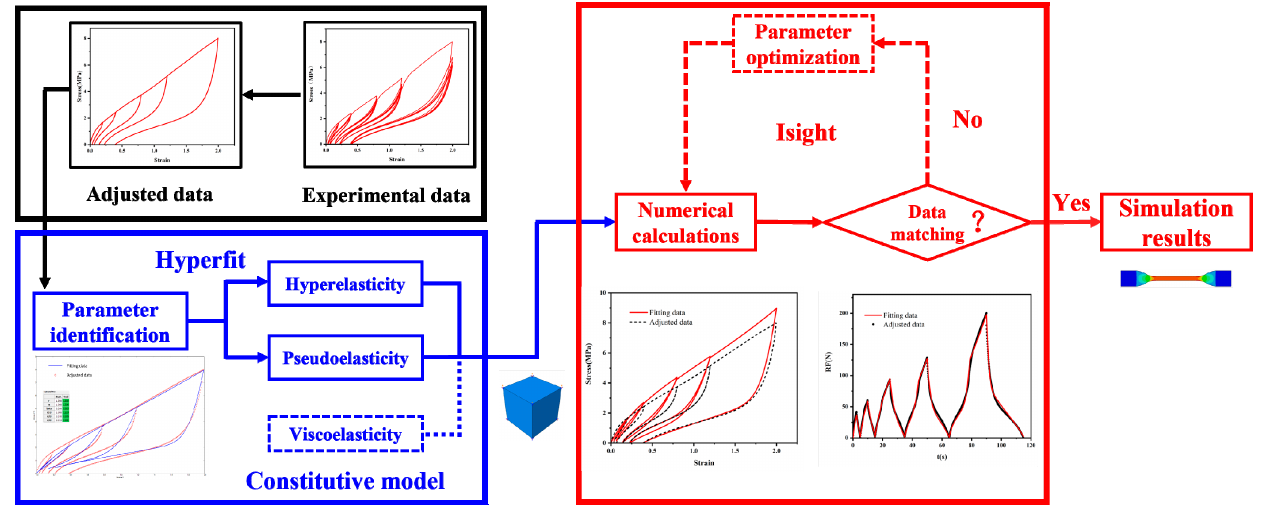
Figure 2. Flow chart of numerical calculation of tensile recovery stress–strain responses of rubber materials.